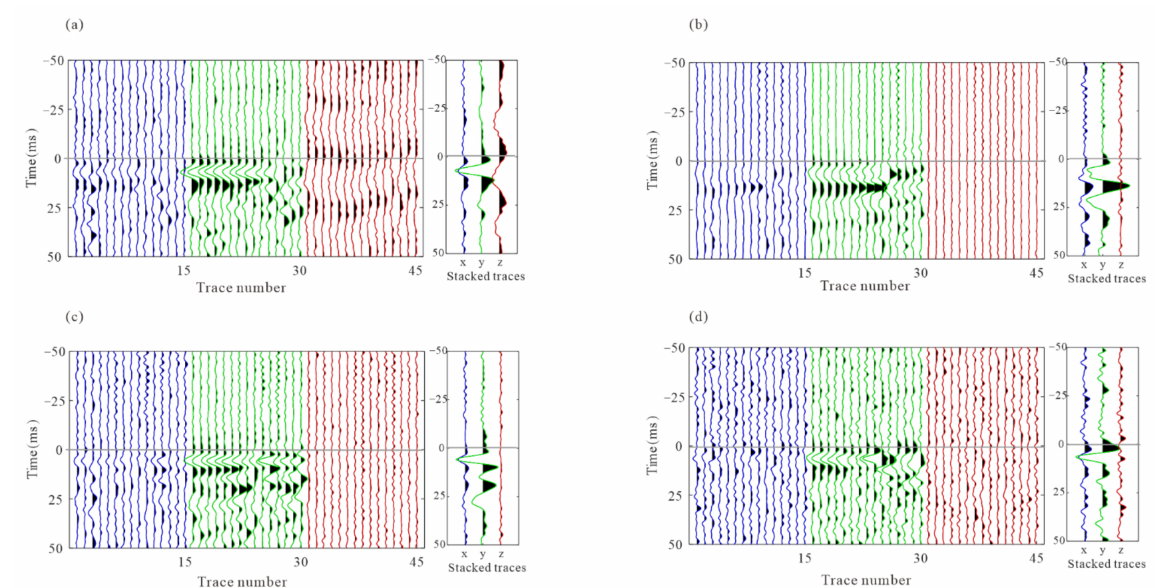
Figure 15. The 3C recording of the example events after residual time correction based on corrected S-wave arrival picks and the stacked waveforms on their right. ( a – d ) are S-wave recordings from the four events in Figure 10. The gray horizontal lines represent the corrected arrival picks of the S-wave. Blue, green, and red lines represent x-, y-, and z- components